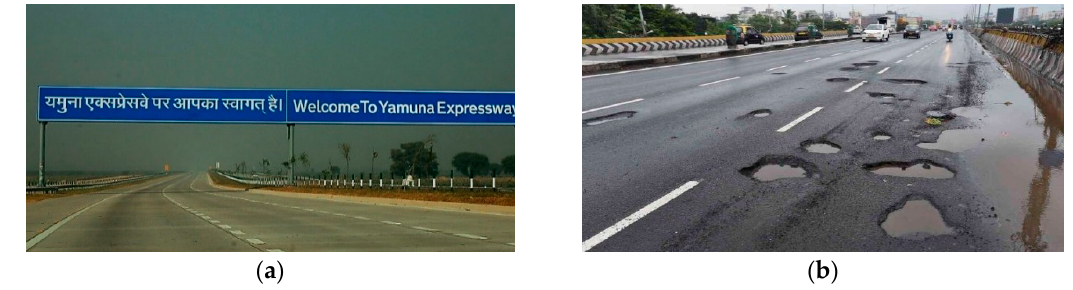
Figure 7. Field test sites for road surface monitoring: ( a ) Yamuna expressway (from Noida to Agra, India); ( b ) potholes on the main roads (Khora, Noida)